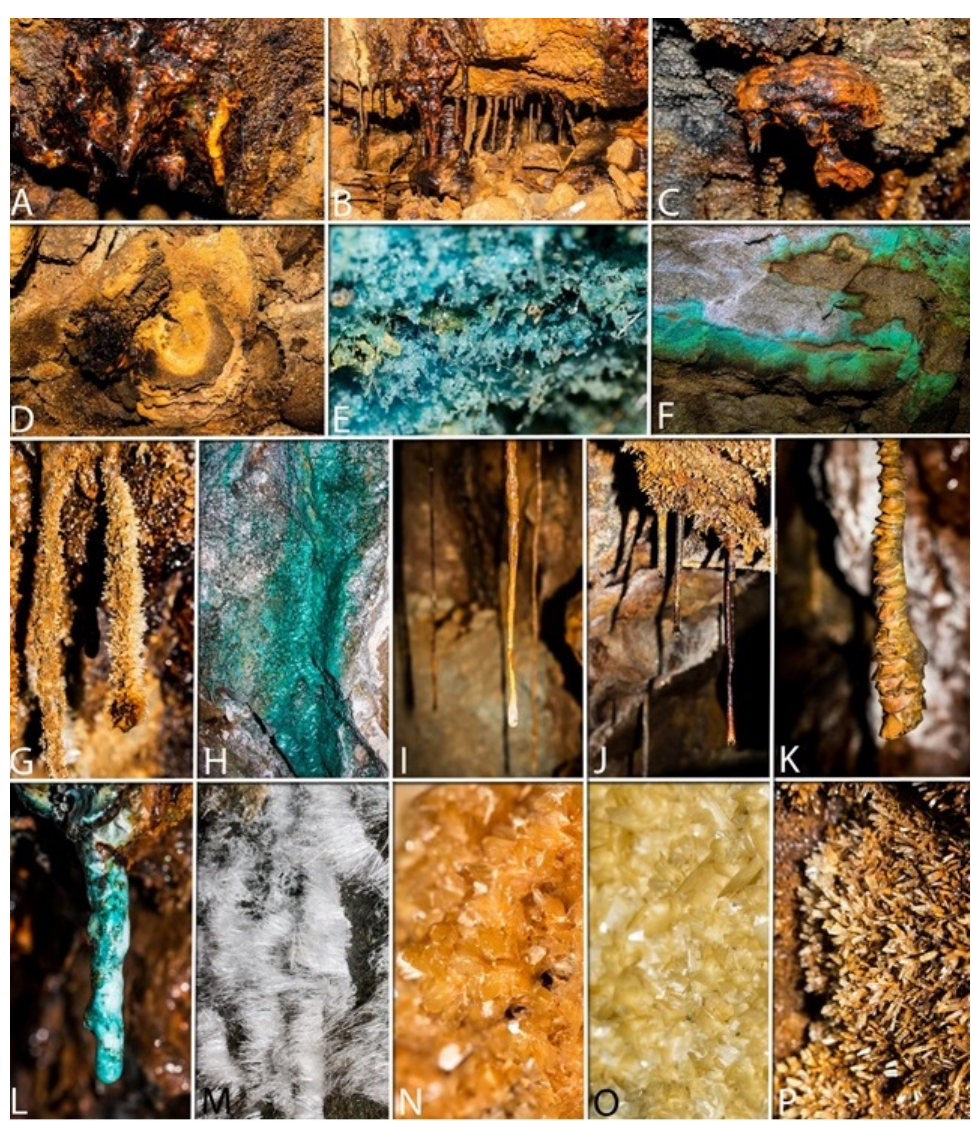
Figure 2. Minothems of Fragnè mine . ( A ) stalactite, Sobrero level; ( B ) column, Sobrero level; ( C ) blister, Sobrero level; ( D ) pancake stalagmite, S. Barbara level; ( E ) crust, S. Barbara level; ( F ) crust, S. Barbara level; ( G ) stalactite, Sobrero level; ( H ) jellystone, Sobrero level; ( I ) jelly stalactite, Sobrero level; ( J ) soda straw, S. Barbara level; ( K ) war club, Sobrero level; ( L ) jelly stalactite, S. Barbara level; ( M ) hair, S. Barbara level; ( N ) crystalline crust, S. Barbara level; ( O ) crystalline crust, S. Barbara level; ( P ) crust of needles, Sobrero level.